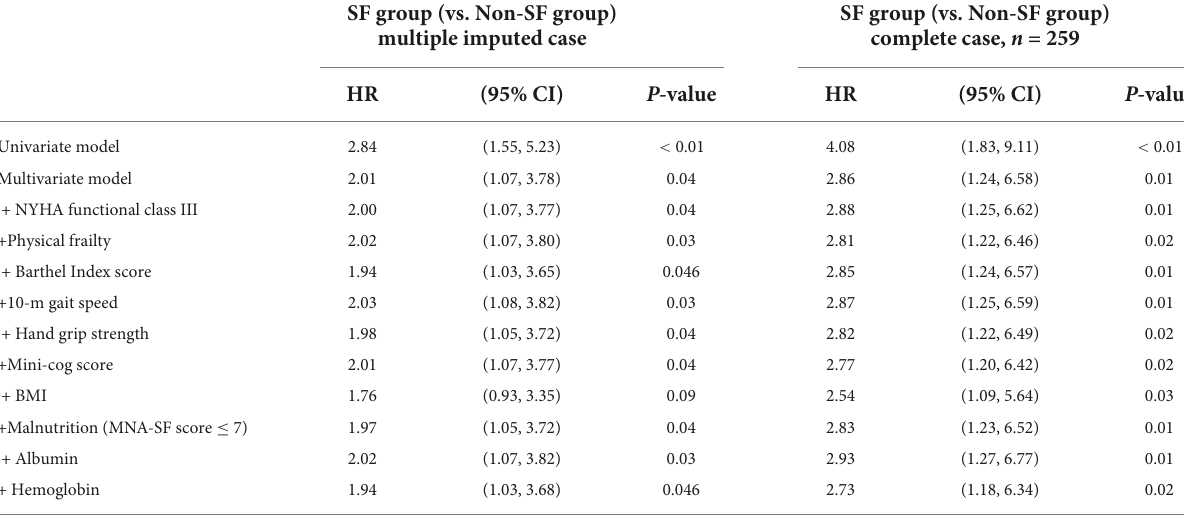
TABLE 2 Univariate and multivariate Cox proportional hazard analysis for composite event according to the presence/absence of social frailty. SF group (vs. Non-SF group) multiple imputed case